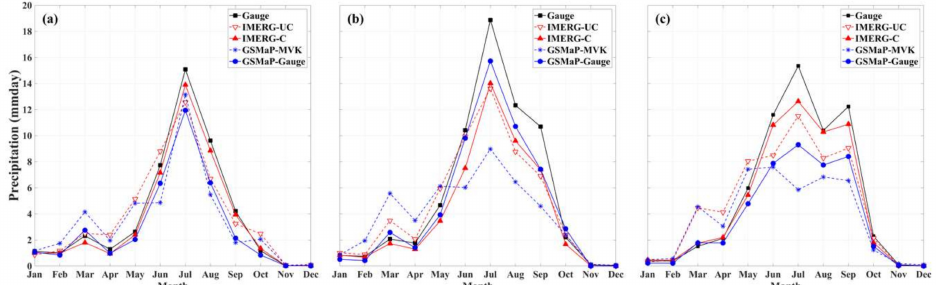
Figure 4. Monthly variation in precipitation (mm / day) over the ( a ) western (80–82ºE), ( b ) central (83–85ºE), and ( c ) eastern (86–88ºE) regions, derived from the gauge observed data and four SBP products averaged over 2015 to